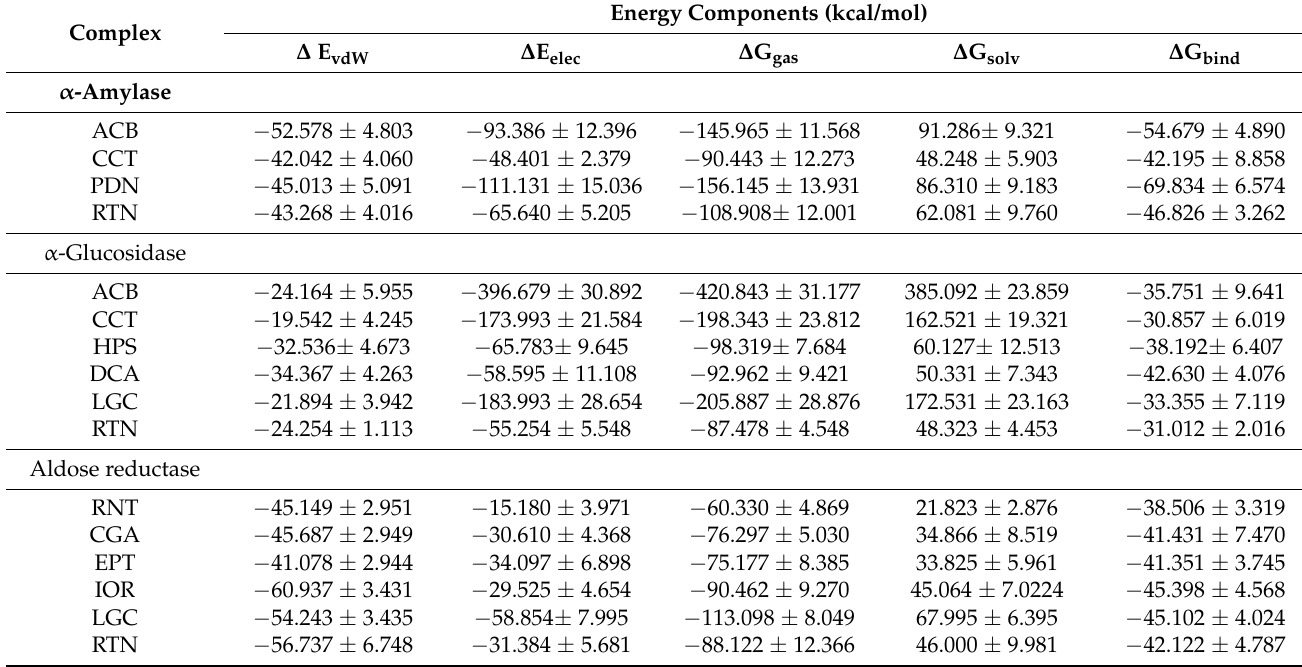
RTN − 56.737 ± 6.748